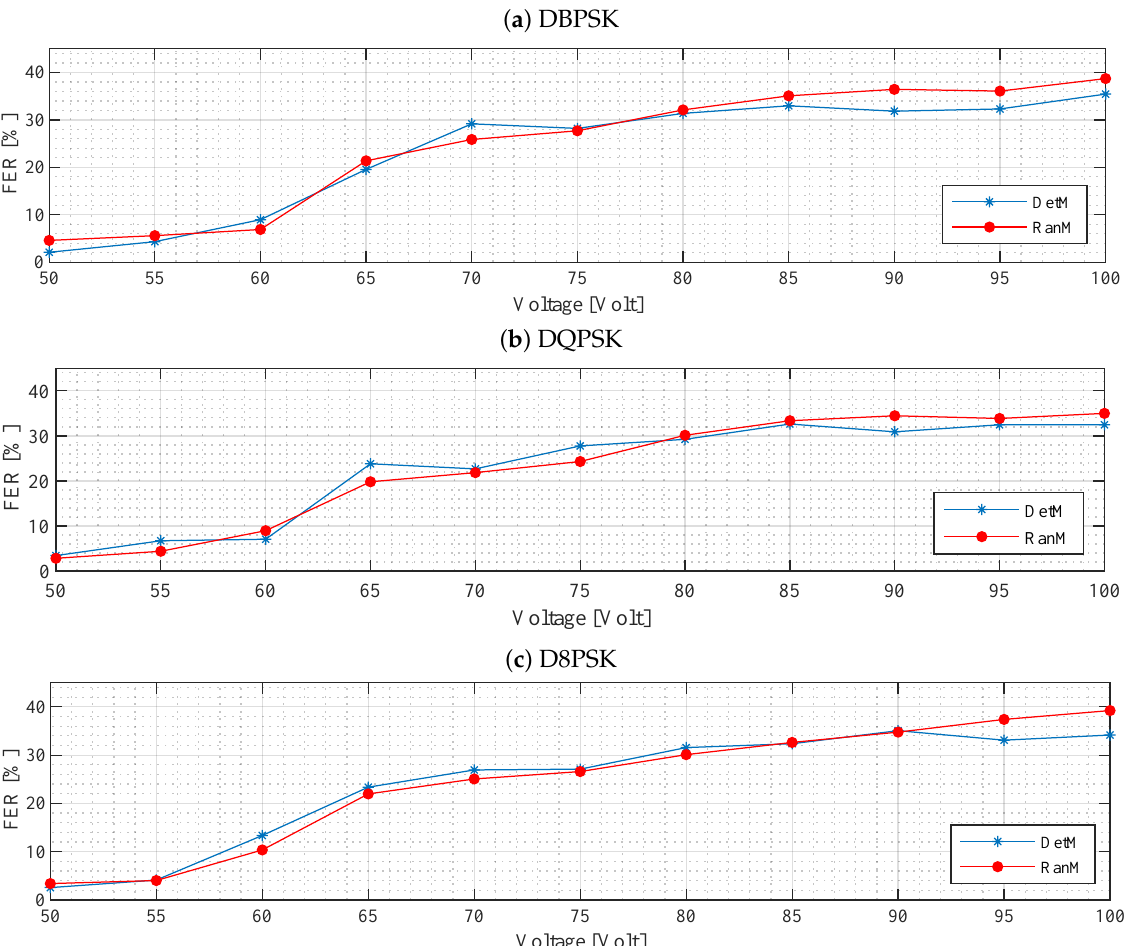
Figure 9. The percentage FER for different output voltages and PLC modulation schemes in the case of using different converter modulations for DBPSK ( a ), DQPSK ( b ), D8PSK ( c